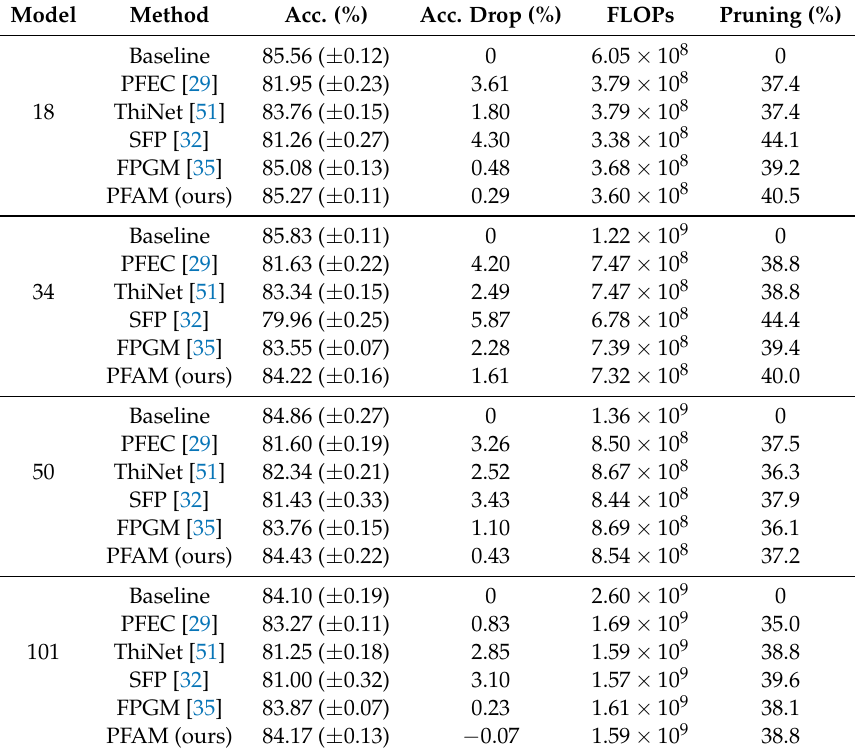
Table 2. Comparison of pruning ResNet on the AID dataset.